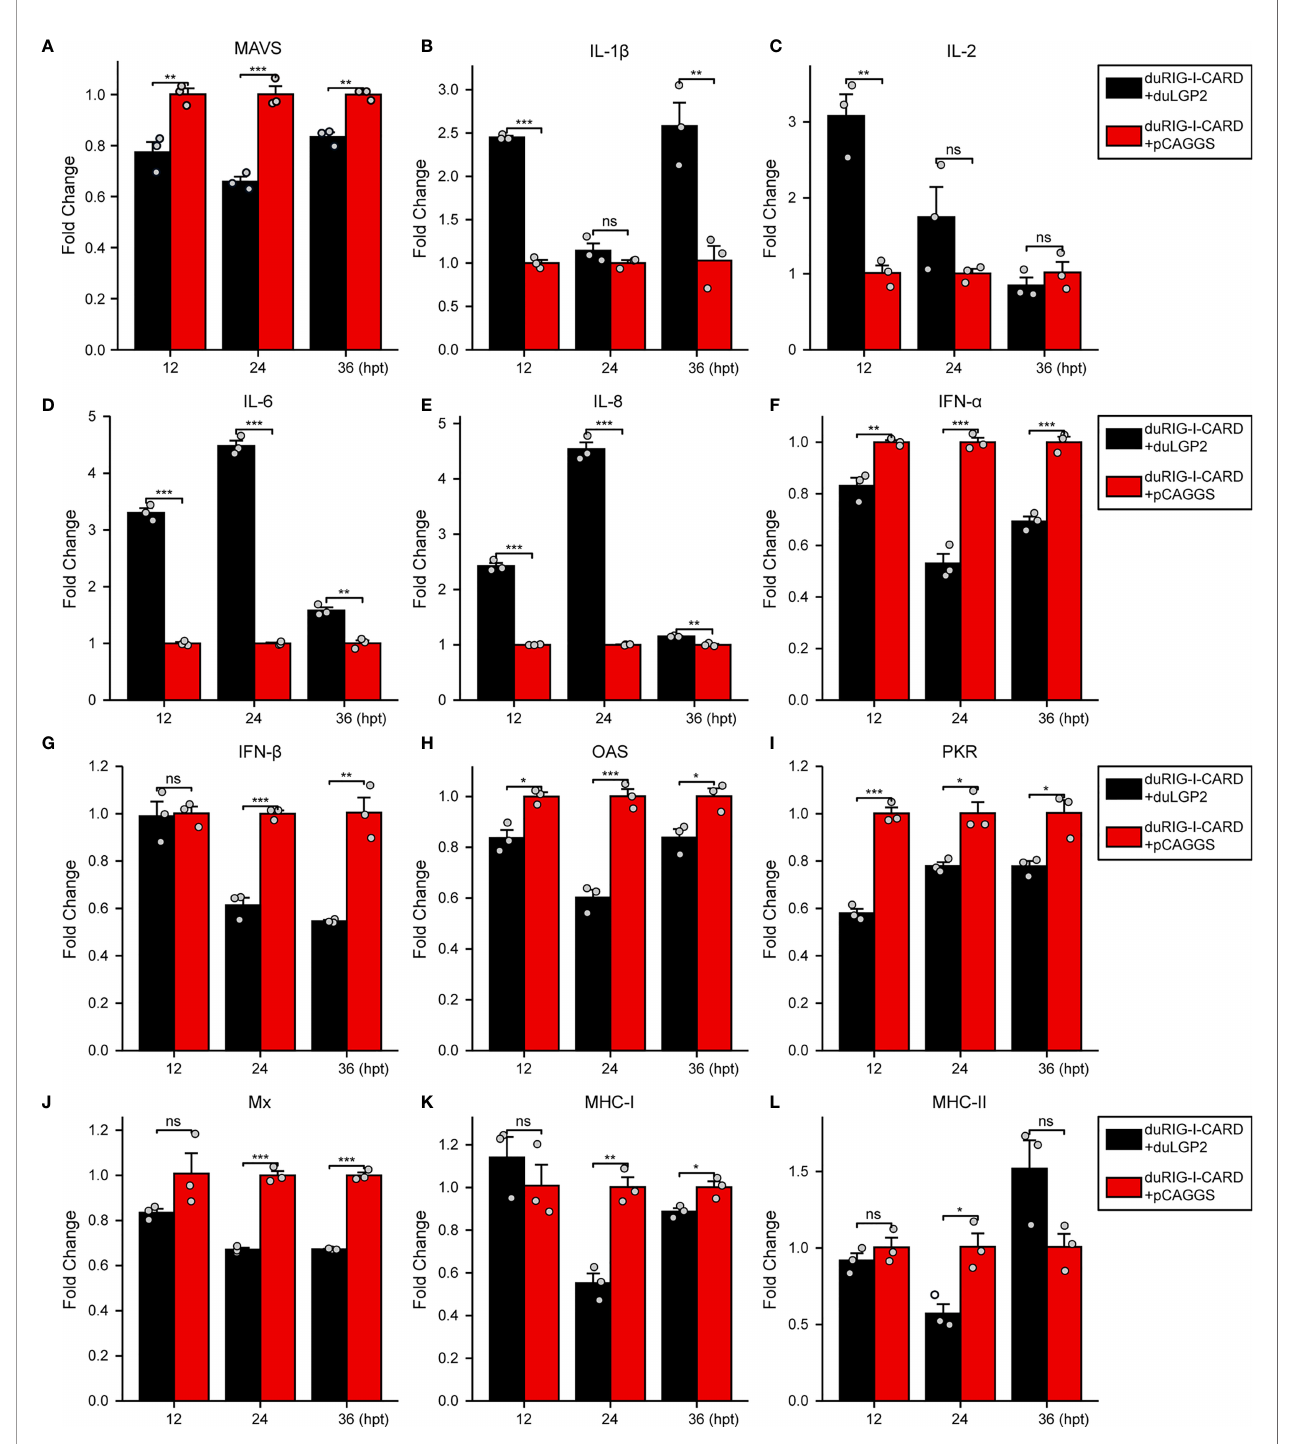
FIGURE 3 | Overexpression of duLGP2 regulates duRIG-I-mediated cytokines expression. DEF cells were transiently co-transfected with indicated expression plasmids or empty plasmids pCAGGS. Cell samples were collected for analysis of cytokine detection at different time points. (A) MAVS (B) IL-1 b (C) IL-2 (D) IL-6 (E) IL-8 (F) IFN- a (G) IFN- b (H) OAS (I) PKR (J) Mx. (K) MHC-I (L) MHC-II. The relative expression of gene mRNA was calculated using the 2 − DD Ct method with GAPDH serving as a normalization gene and mean control values as a baseline reference, and the values in the control groups (pCAGGS co-transfection) were set to 1. All samples were analyzed in triplicate, and all data were expressed as means ± SEM. *Signi fi cant difference ( P < 0.05); **Highly signi fi cant difference ( P < 0.01); ***Extremely signi fi cant ( P < 0.001); ns, no signi fi cant